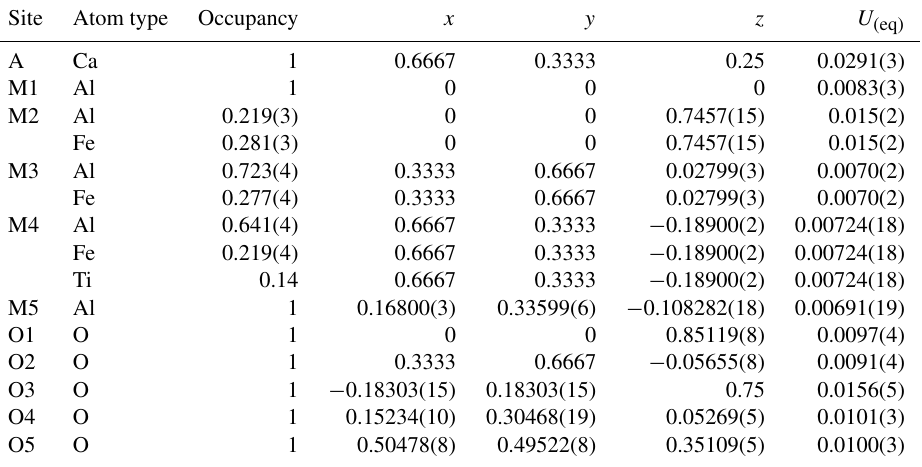
Table 5. Hibonite relative atomic coordinates and equivalent isotropic displacement parameters. The M2, M3, and M4 sites show a mixed occupancy.